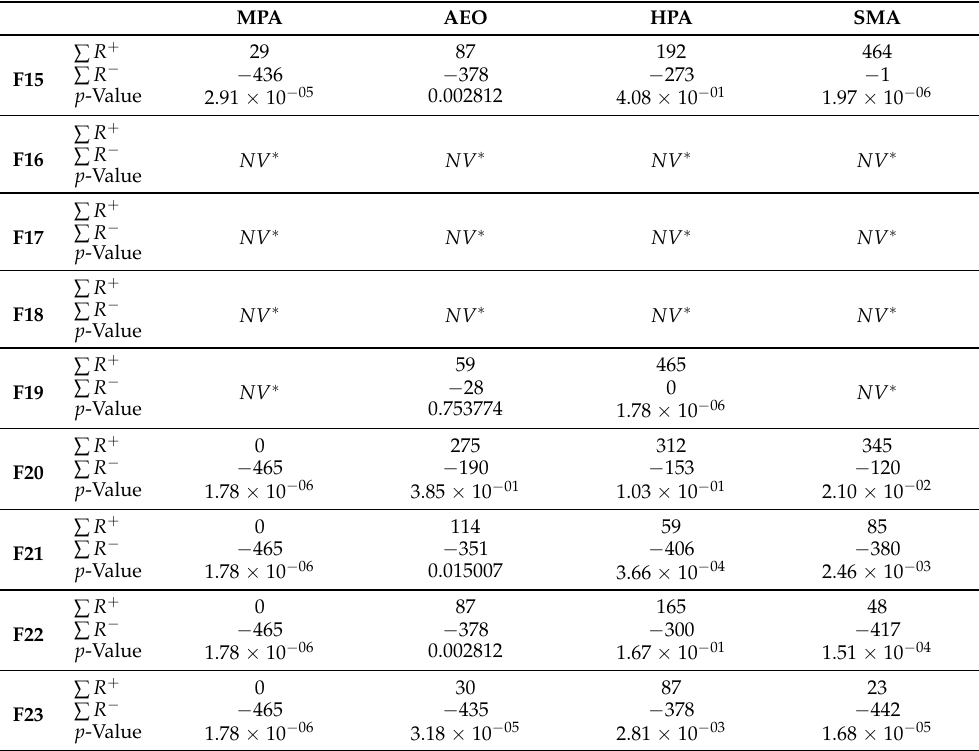
Table 7. Nonparametric test using WSRT values for composite benchmark functions.